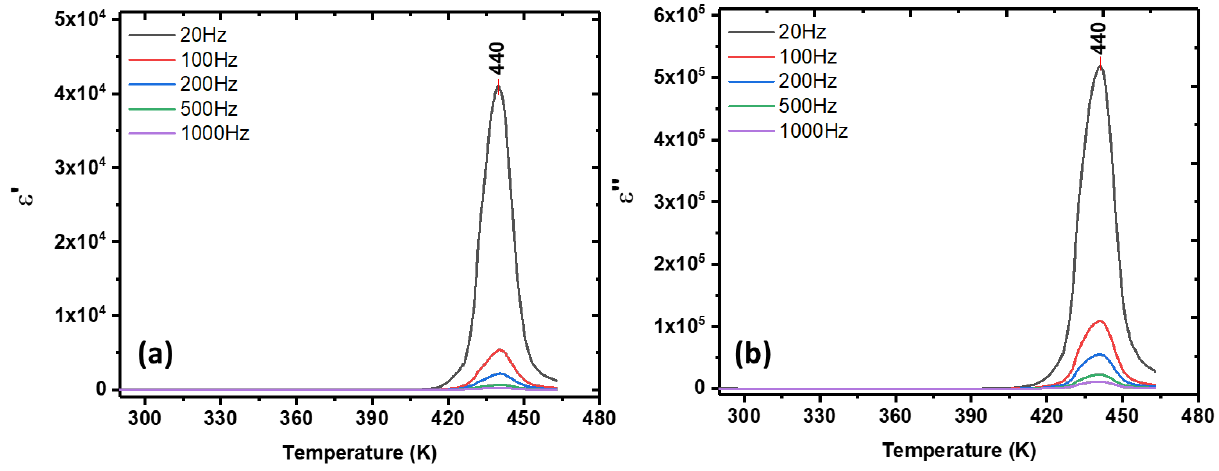
Figure 9. Dielectric permittivity of an MDABCO-NH 4 I 3 polycrystalline sample showing its ( a ) real and ( b ) imaginary parts as functions of temperature and frequency. The ferroelectric–paraelectric phase transition occurs at 440 K.